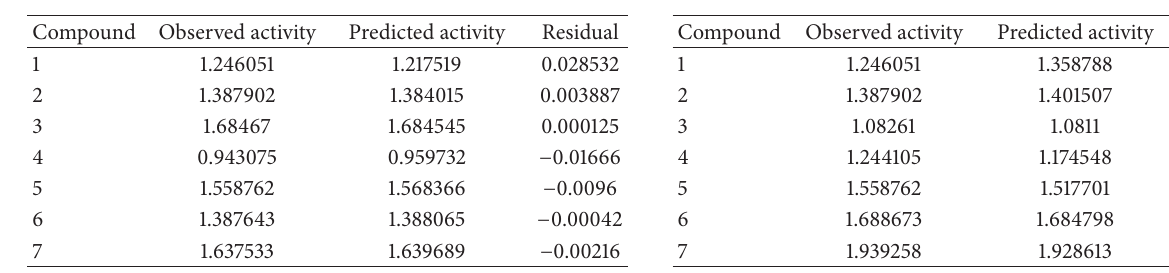
Table 8: Observed and predicted antibacterial activity of synthe- sized benzamide substituted Mannich bases against Enterococcus faecalis